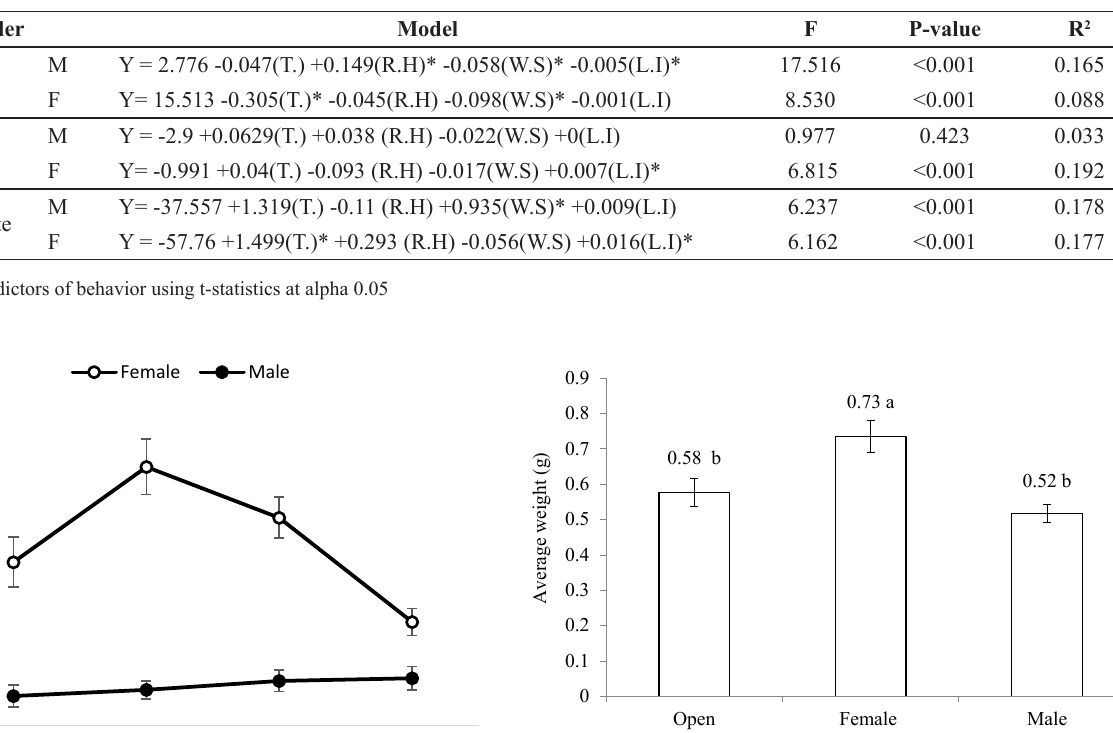
Table 3 . Multiple regression analysis between foraging behaviors of female and male M. cephalotes and environmental factors (M=male, F=female, T=temperature, R.H=relative humidity, W.S= wind speed, L.I=light intensity).